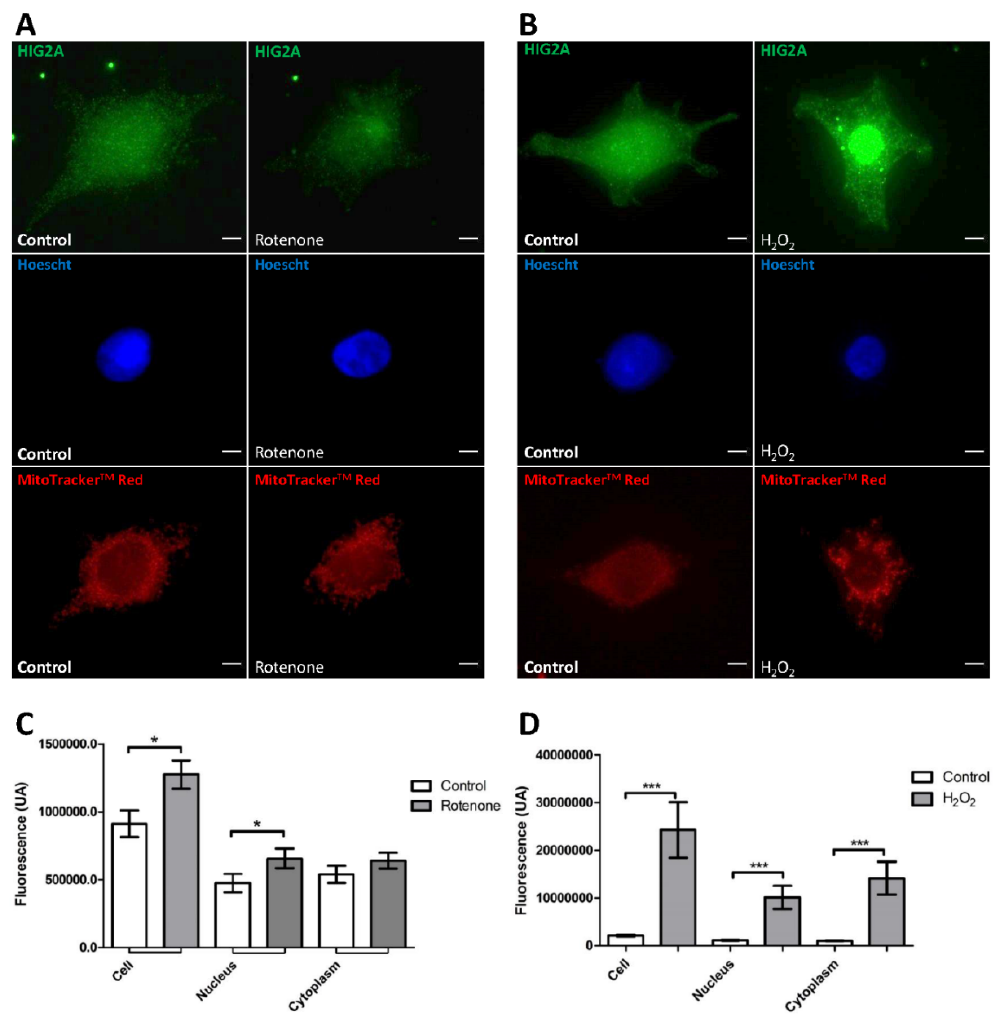
Figure 1. The effect of oxidative stress on HIG2A levels. Representative immunofluorescence images in HEK293 cells; Anti-HIG2A primary antibody, DyLightR 488 secondary antibody (Green). MitoTracker TM Red CM-H2XRos mitochondrial fluorescent marker (Red). Hoescht 33342 (blue signal after binding to DNA). The images were obtained by epifluorescence microscopy (Leica DMI6000). The HEK293 cell line was stressed with 20 nM rotenone for 1-h ( A , C ) and with 100 µ M hydrogen peroxide (H 2 O 2 ) for 1-h ( B , D ). The fluorescence of HIG2A in the whole-cell and nucleus was quantified through ImageJ software 1.52p. The fluorescence intensity is represented as an arbitrary unit (AU). Each bar graph represents the mean ± SE, n = 4 biological replicates, number of cells that were analyzed in total (N ◦ ): Rotenone N ◦ = 57, Control (rotenone) N ◦ = 22; H 2 O 2 N ◦ = 98, Control (H 2 O 2 ) N ◦ = 67. They were analyzed by a one-tailed t -test ( p ≤ 0.05), followed by a Mann-Whitney test. Statistical differences were found with a significance of p -value (*). Bars indicate a 5 µ m scale. (* p -value ≤ 0.0292; *** p -value ≤